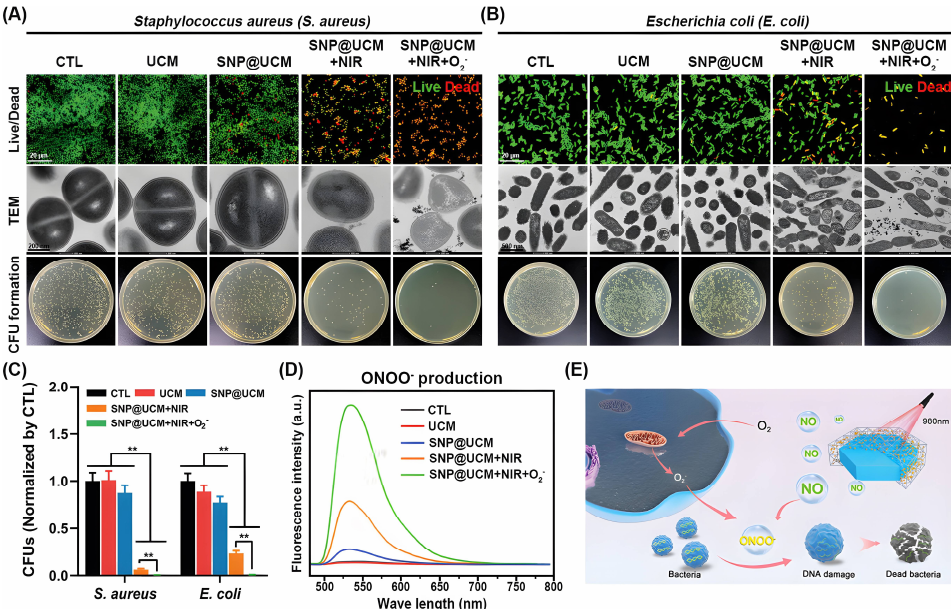
Figure 6. In vitro antibacterial activity of SNP@UCM nanogenerators. ( A , B ) Antibacterial activity of the indicated treatments against S. aureus ( A ) and E. coli ( B ) as determined by bacterial live/dead staining, transmission electron microscopy (TEM) analysis, and colony-forming unit (CFU) counts. ( C ) Quantitative analysis of CFUs. ( D ) ONOO − production by bacteria under the indicated treatments. ( E ) Schematic of the proposed antibacterial mechanism. NO released from SNP@UCM reacted with ROS produced during the bacterial invasion to form ONOO − . ONOO − destroyed bacterial membrane integrity. ** p < 0.01. Reproduced with permission [153]. Copyright 2021, Advanced materials